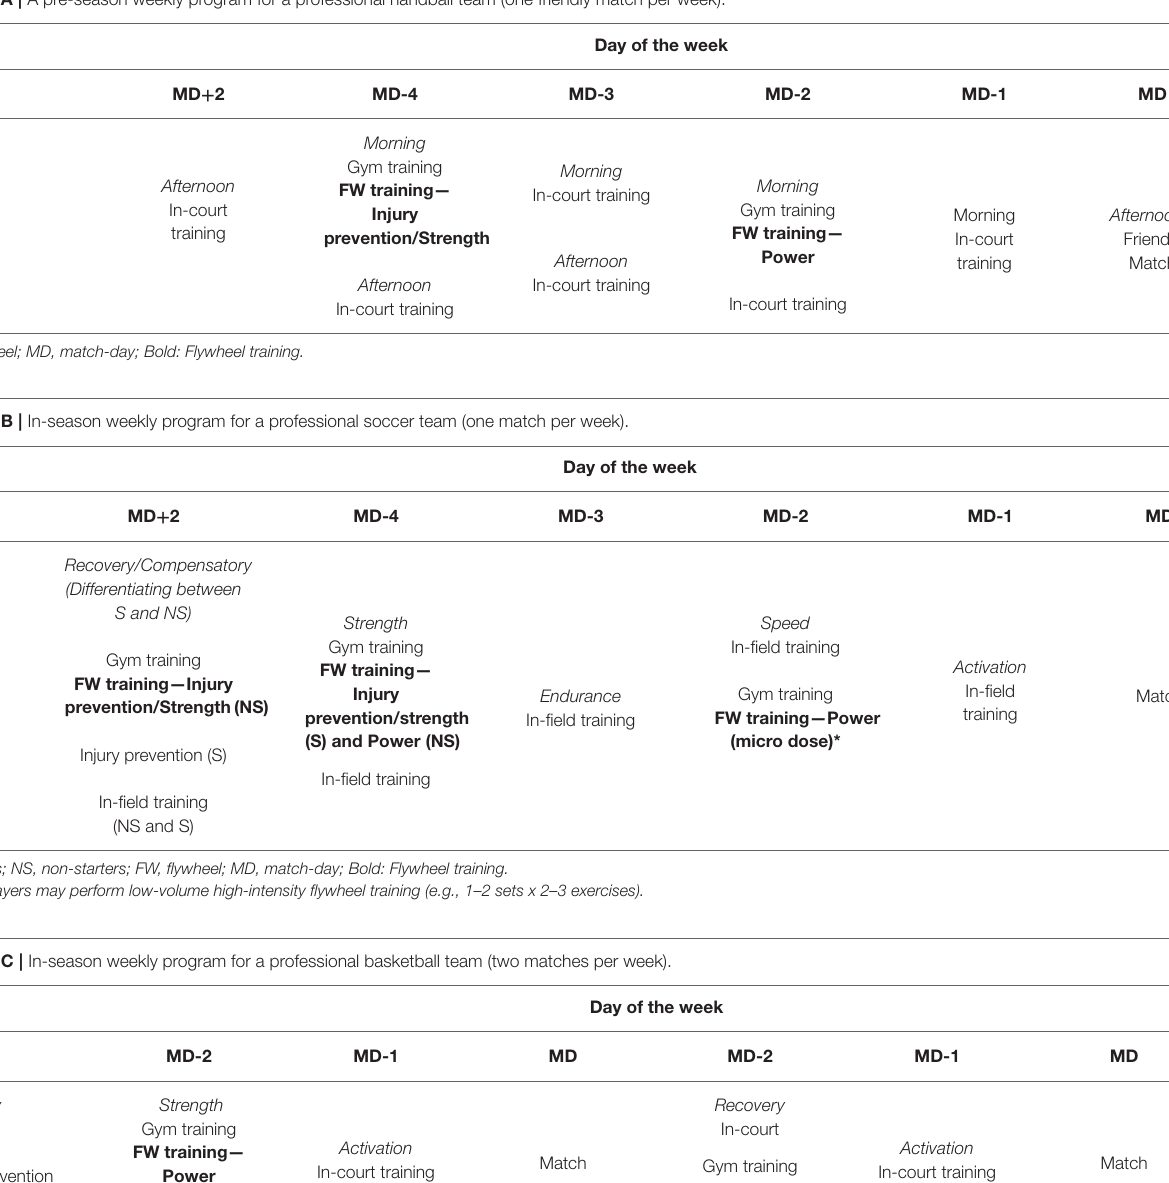
TABLE 1A | A pre-season weekly program for a professional handball team (one friendly match per week).